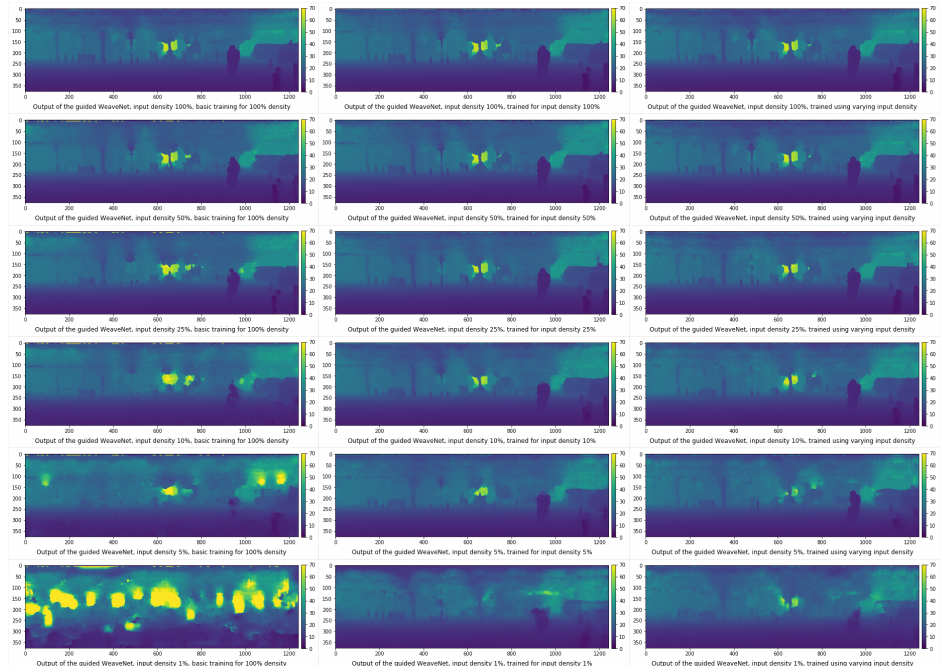
Figure 9. Output of the guided WeaveNet for various densities for different training modes (basic training on the left, training for specific density in the middle, training for variable density on the